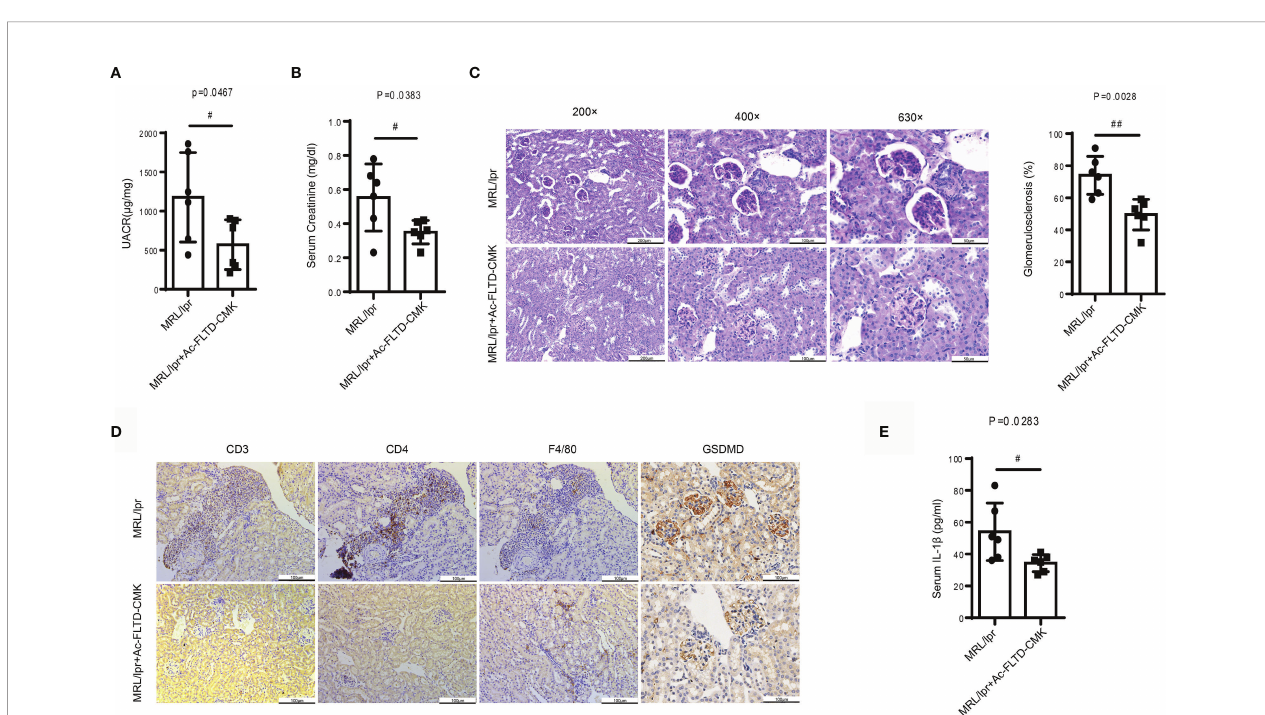
FIGURE 5 | Ac-FLTD-CMK, a GSDMD-derived inhibitor, prevented the development of LN. (A) The urine albumin-to-creatinine ratio was calculated in MRL/lpr mice given or not given a GSDMD inhibitor. (B) Serum creatinine in MRL/lpr mice given or not given a GSDMD inhibitor. (C) Representative images of kidney specimens stained with Periodic acid – Schiff (PAS) and quanti fi cation glomerulosclerosis percentage. (D) Immunochemical staining of CD3, CD4, F4/80 and GSDMD. (E) Quanti fi cation of serum IL-1 b concentrations in MRL/lpr mice given or not given a GSDMD inhibitor. Data are shown as the mean ± SEM. # p < 0.05, ## p <